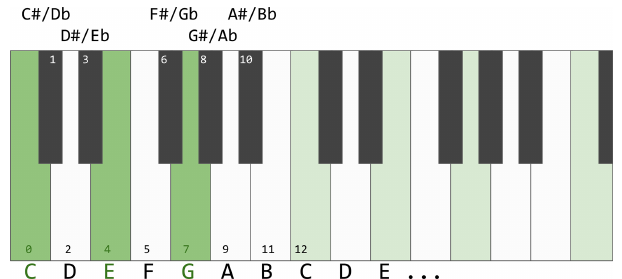
Figure 3. A depiction of a standard piano keyboard showing the names of the notes and the number of these notes in MIDI format. The C major chord is highlighted in green, and the zeroth octave is shown in a darker green than the subsequent